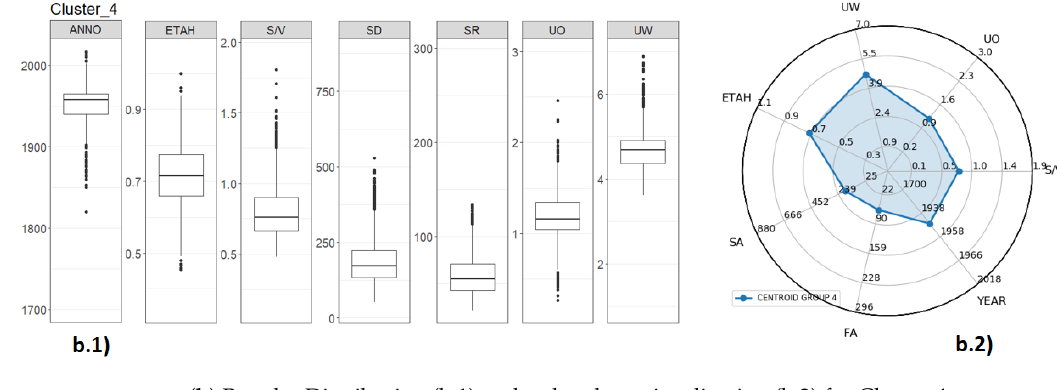
Figure 2. Cluster 0 in ( a ) represents a group of high performance buildings, while cluster 4 in ( b ) represents a group of low performance buildings.